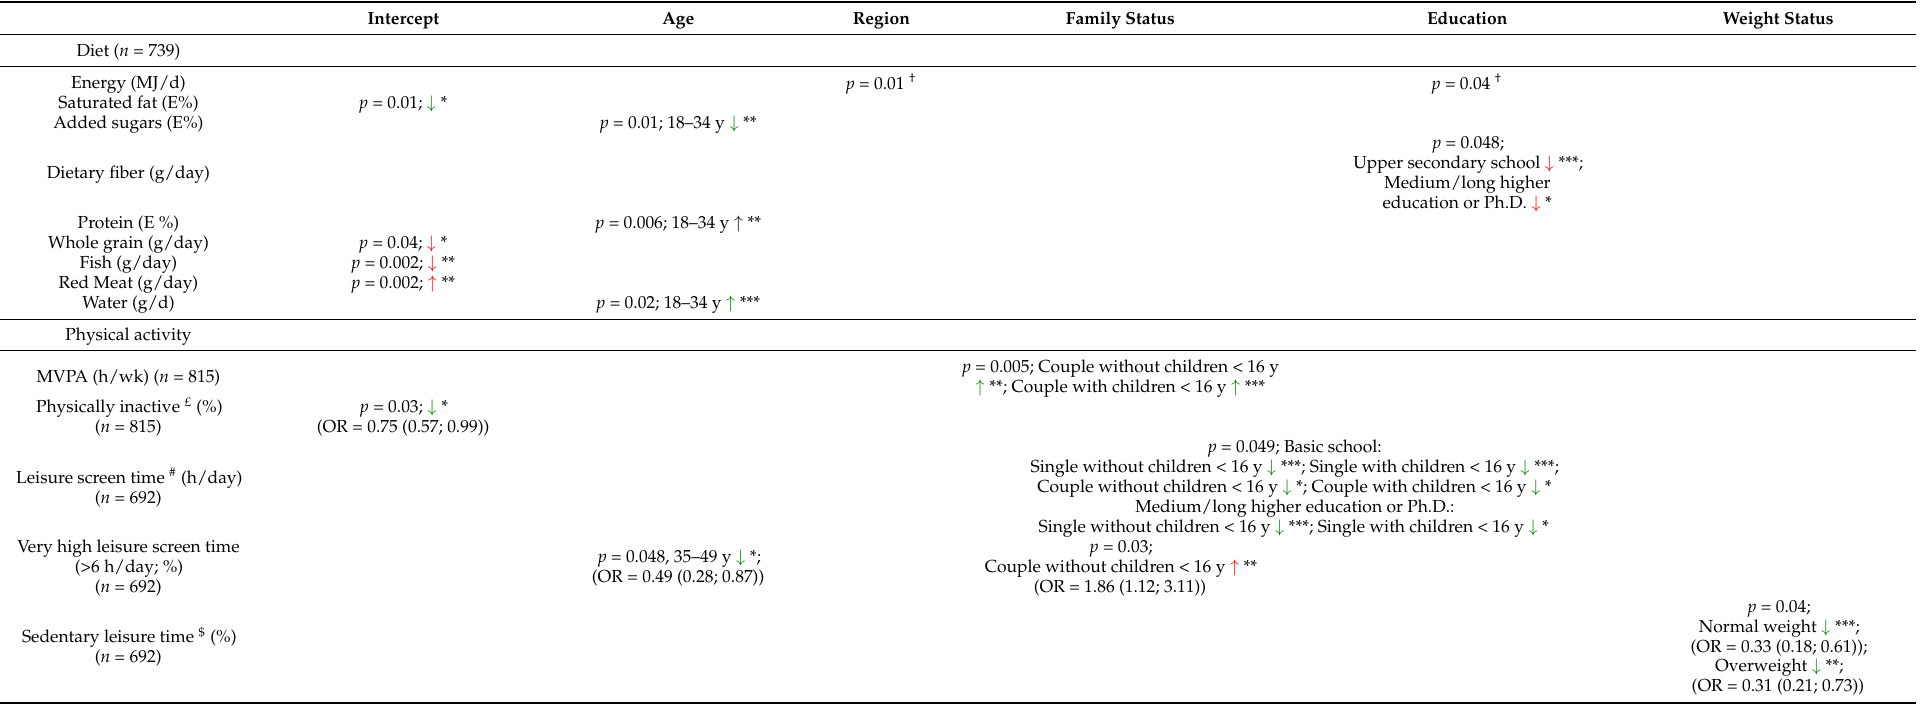
Table 3. Change in diet and physical activity among Danish adults moderated by sociodemographic characteristics and weight status assessed during and after the lockdown using statistical